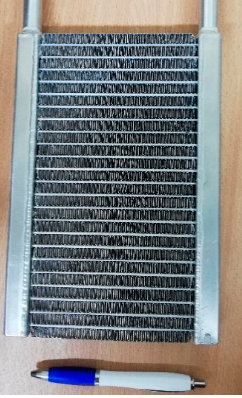
Figure 2. Small-scale aluminum heat exchanger [30].